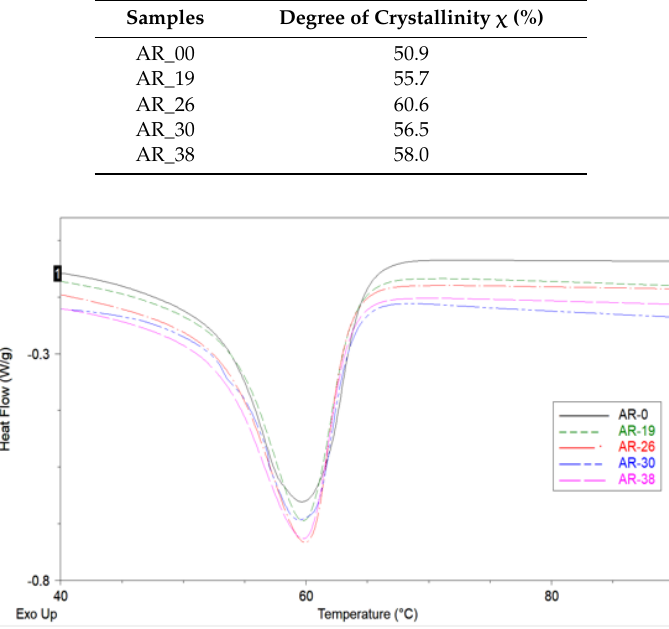
Figure 6. Typical DSC thermogramms of both neat PCL matrix samples (AR_0) and hemp/PCL composite samples (AR_19, 26, 30 and 38), depicting the heat flow at an increasing temperature.